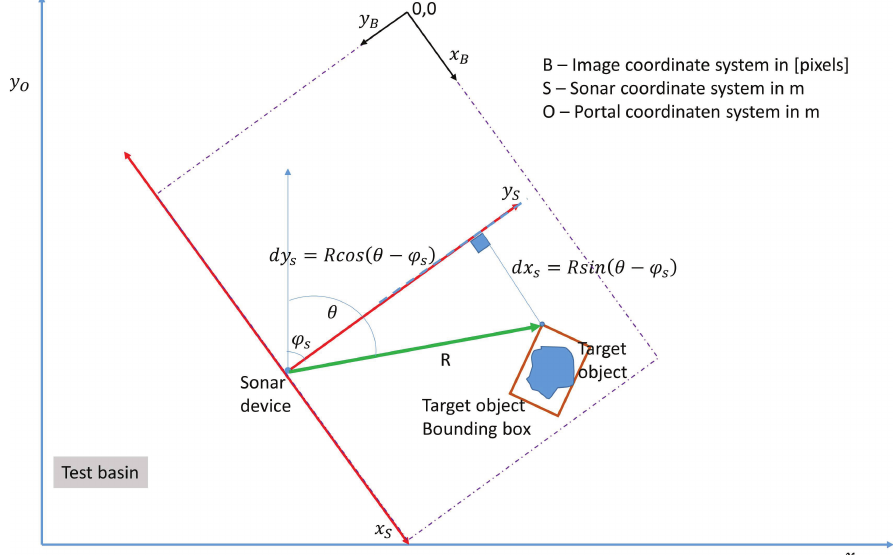
Figure 5. Geometric calculations for automatic conversion of real coordinates into sonar image coordinates for automatic image